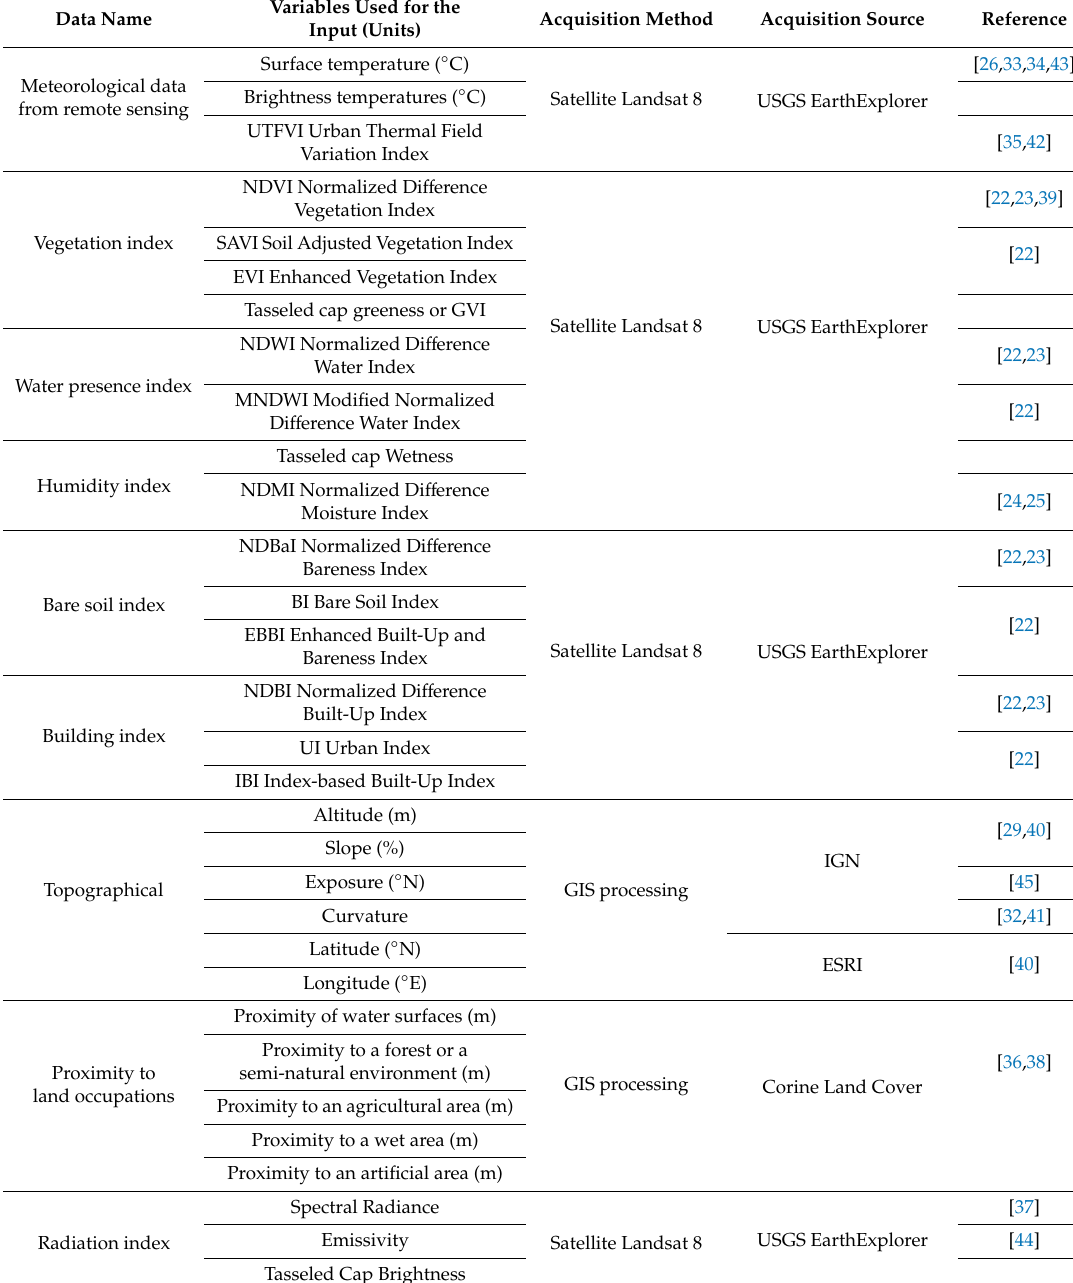
Table 3. List of explanatory variables selected to estimate fine-scale air